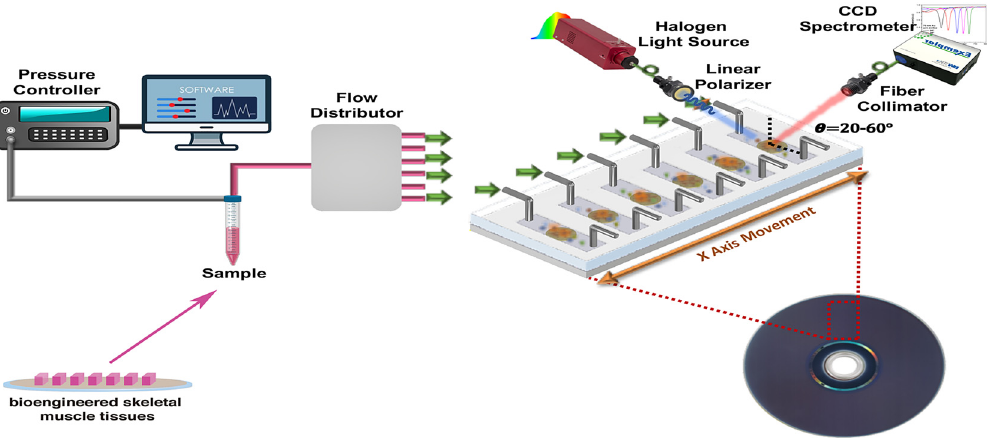
Figure 1: Schematic representation for developing a high throughput multichannel 1D plasmonic nanocrystals-based sensing platform for monitoring IL-6 levels in cell culture media supernatants from bioengineered 3D